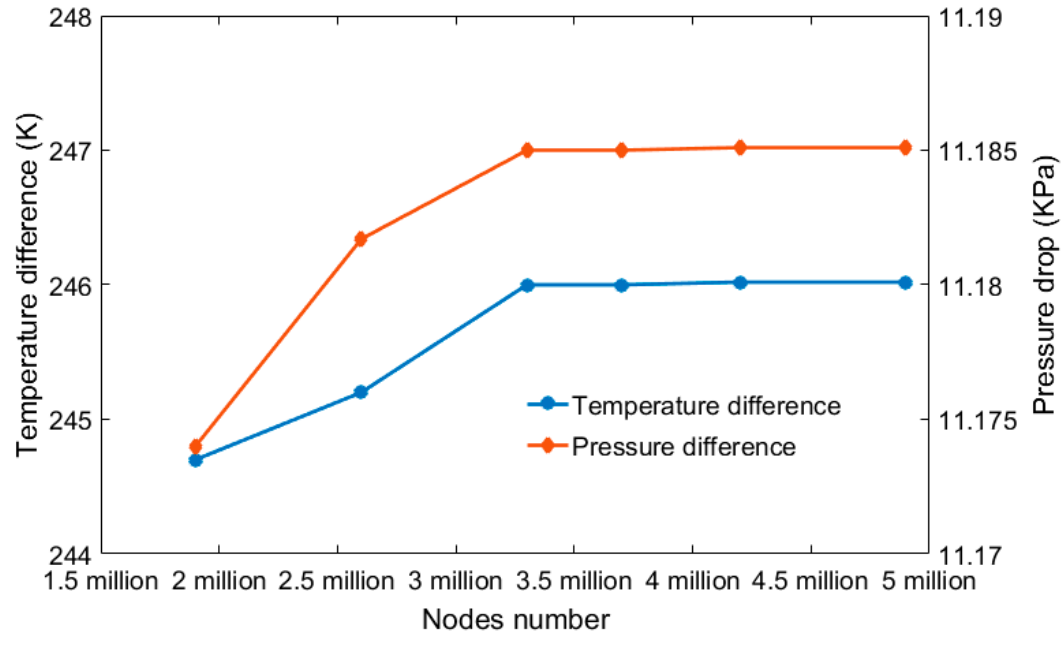
Figure 4. Grid independence test.